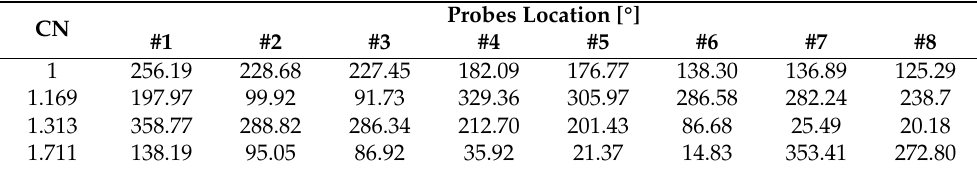
Table 3. Probe location set used for the test. Each set was calculated for per-rev = 200 and different condition numbers